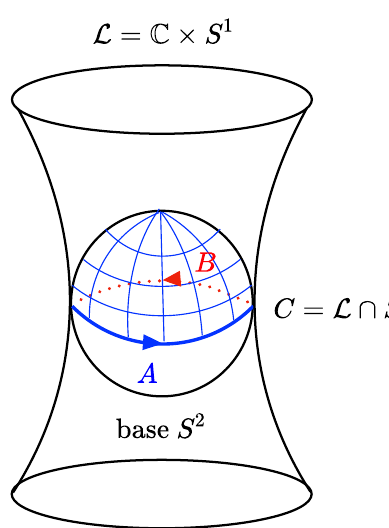
. These end on the A